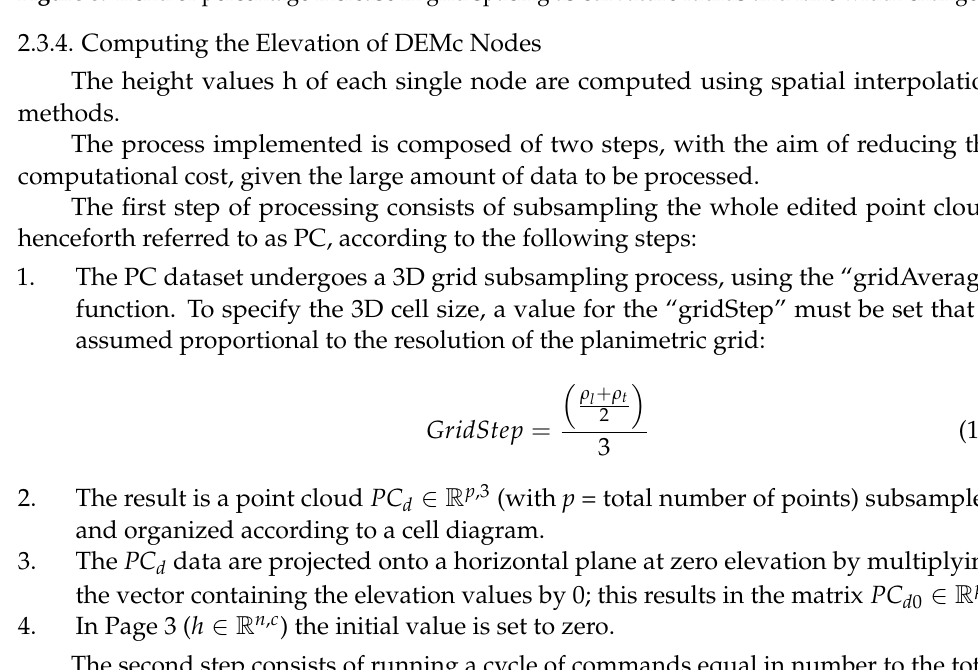
Figure 8. Trend of percentage increase in grid spacing as curvature radius and lane width change.